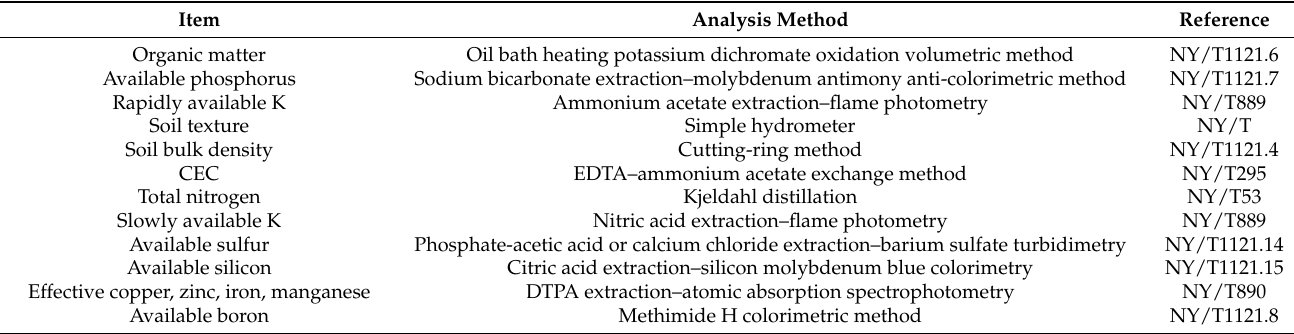
Table 1. Soil sample components and the corresponding methods of